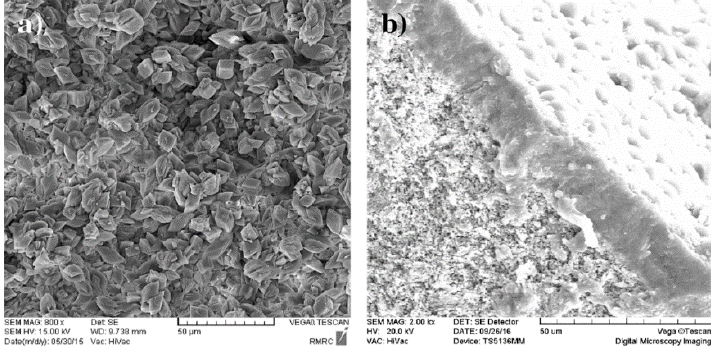
Figure 6. SEM images of the synthesized DD3R membrane (a) surface and (b) cross